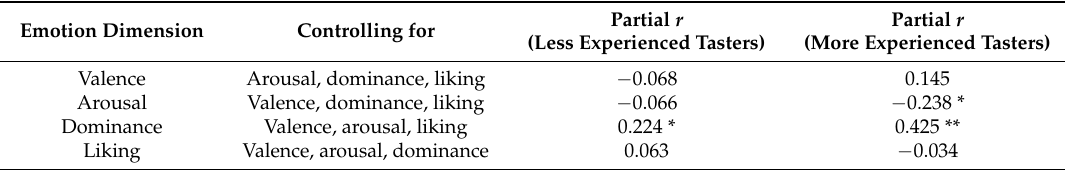
Table 3. Partial correlation coefficients ( N = 189) between participants’ wine–music matching scores and emotion similarity ratings for more and less experienced wine tasters. * indicates significance at the 0.05 level, ** indicates significance at the 0.01